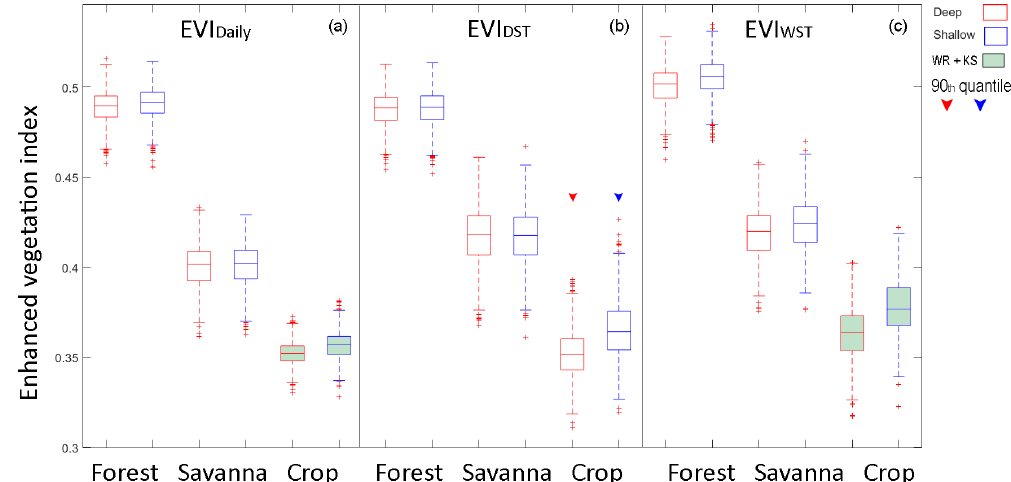
Figure 6. (a) Average enhanced vegetation index (EVI) annually EVI daily , (b) during the dry season transition period EVI DST , and (c) during the wet season transition EVI WST . Red boxes represent deep WTD. Blue boxes represent shallow WTD. Green filled boxes represent statistical differences by both Wilcoxon-rank and Kolmogorov–Smirnov tests. Significant differences in the 90th quantile are depicted by the